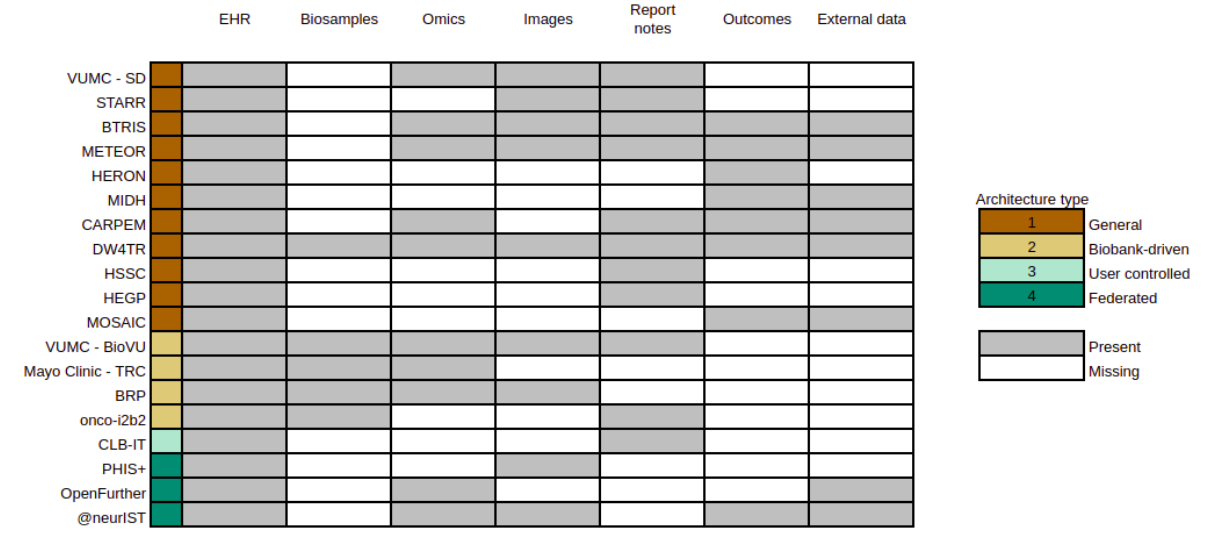
Figure 3. Common data types across IDRs. Columns show the main types of data collected in the selected IDRs. Gray-filled cells denote feature presence, with colors classifying the IDRs based on the examined architectures. Only 19 IDR articles contained enough information in their articles to be included in this figure. BRP: biorepository portal; BTRIS: biomedical translational research information system; CARPEM: cancer research